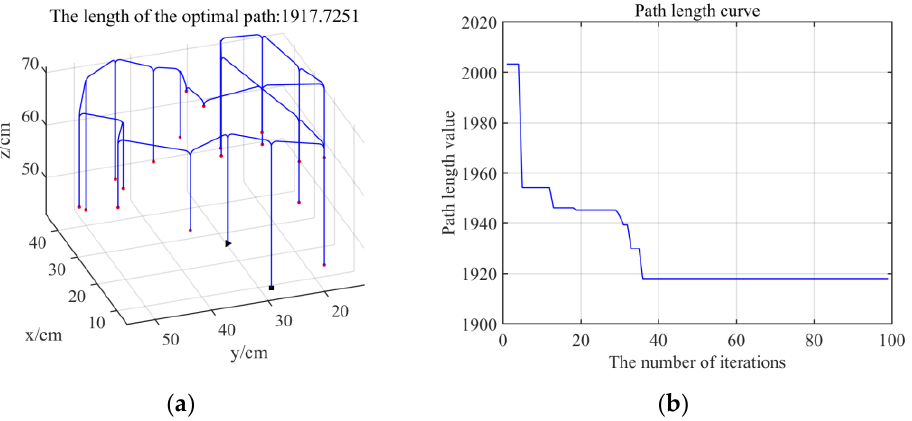
Figure 12. The fixed plane ∩ -shaped track: ( a ) Simulation of picking path results; ( b ) Path length change curve.